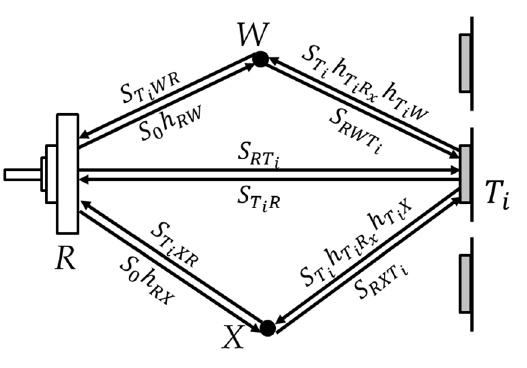
Figure 1. The signal propagation model.